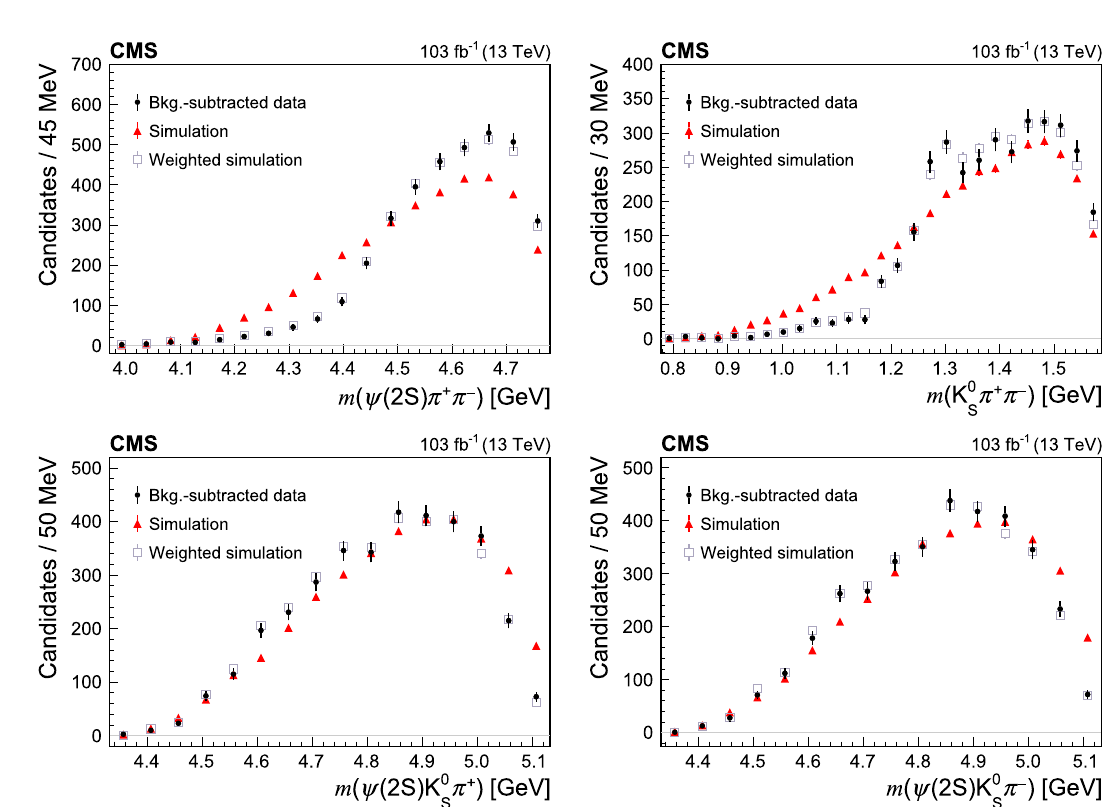
Fig. 3 Distributions of 3-body intermediate invariant masses from the + π − decay. Data distributions (black dots) are back- B 0 → ψ ( 2S ) K 0 S π ground subtracted. Overlaid are the predictions of phase space sim-